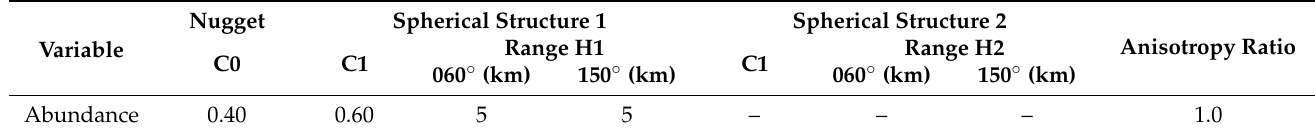
Figure 29. Omni-directional and 060° directional variograms for percent nodule coverage estimated from seafloor photos. Source: [12]. Ordinary kriging was used to estimate the nodule abundance, along with manga- nese, nickel, copper, and cobalt, for every cell in the block model. Panel support (volume) was approximated by estimating the values on a three by three (nine points) grid equally spaced within each block, with the point estimates averaged to give the block estimate. For each estimate, a circular neighbourhood with a radius of 30 km was used to find the closest samples (a minimum of one and maximum of 32). If no samples were found within the first 30 km, then the search radius was increased to 60 km and then 90 km to ensure that every block was estimated. The relatively large number of samples used for estimat- ing a value for a block was chosen to ensure that the block estimates were smoothed to reflect the confidence in the estimate. Estimate checks were done using the nearest neigh- bour and inverse distance weighing interpolation techniques [12].